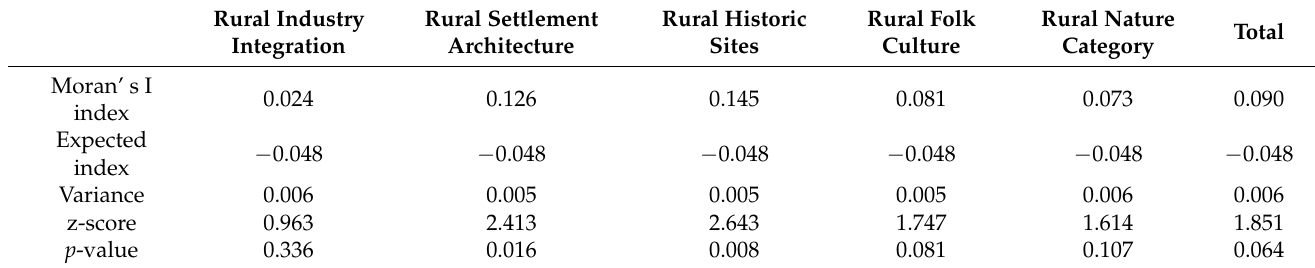
Table 3. Moran’s I estimated value statistics of various types of rural tourism resources.